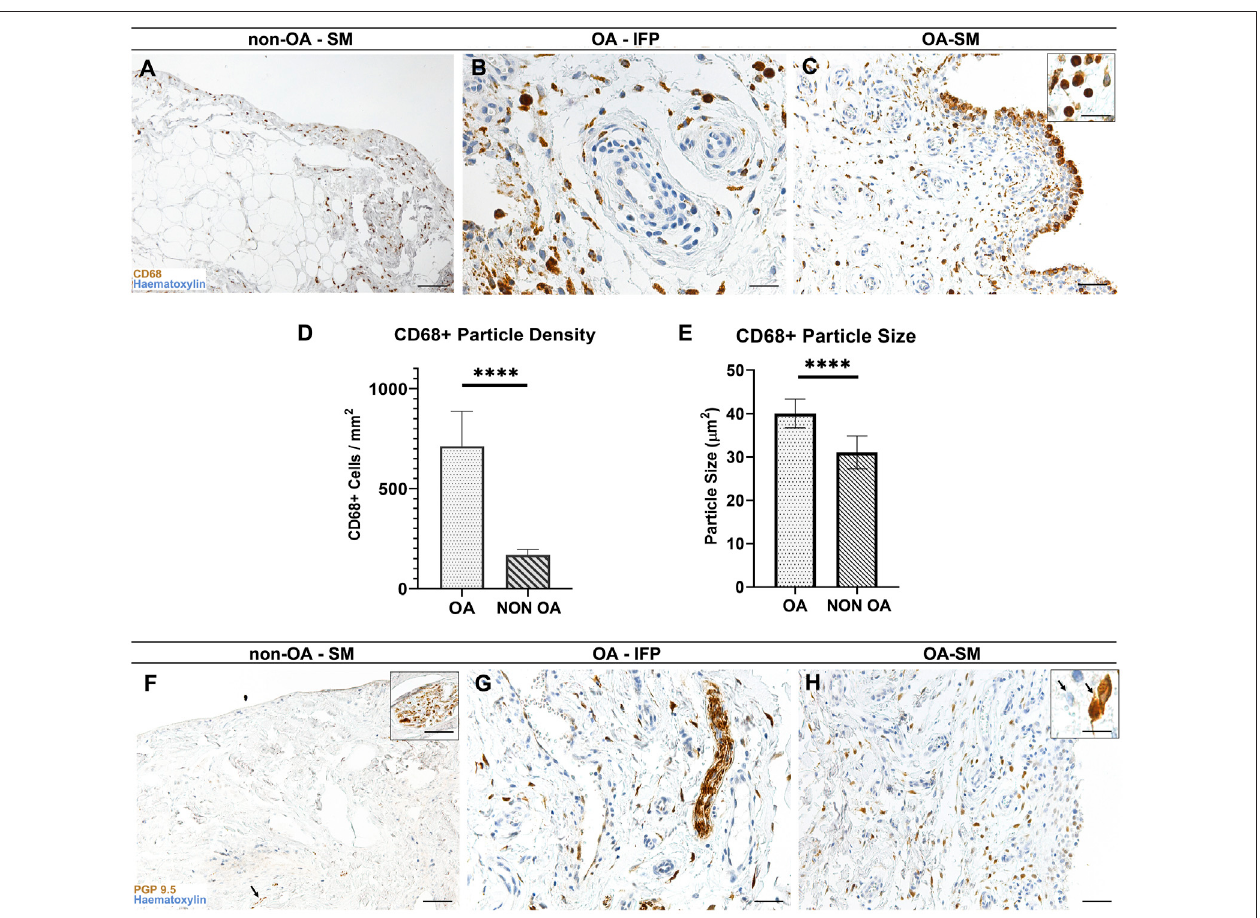
FIGURE4|(A – C) CD68 + patterndistributionwithinthenon-OA (A) anddiseased (B , C) AFUsbyimmunohistochemistry. (D , E) CD68 + elementscharacteristicsby morphometric analysis: Welsch-corrected t -test of CD68 + particle size (D) and density (E) reveals statistically signi fi cant differences between OA and OA-free subjects (**** p < 0.0001). (F – H) PGP9.5 immunoreactivity in the healthy (F) and diseased (G , H) AFUs. Scale bars: 100 µm (A , C , F , H) ; 50 µm (B , G) . Scale bars inserts: 25